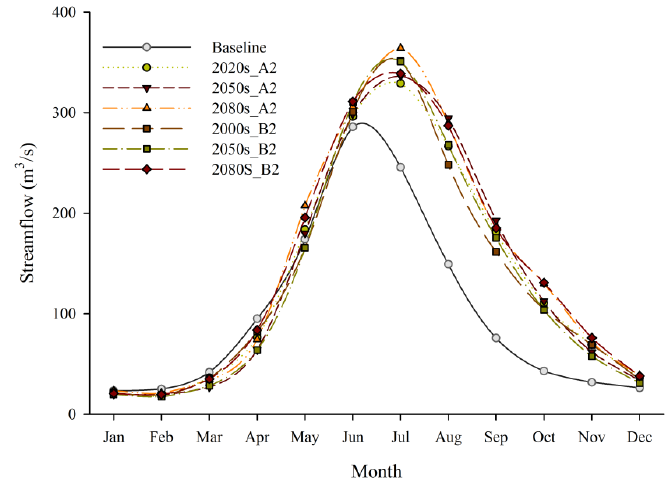
Figure 9. Future shift of peak flows in timing and magnitude under A2 and B2 in the Kunhar River basin.